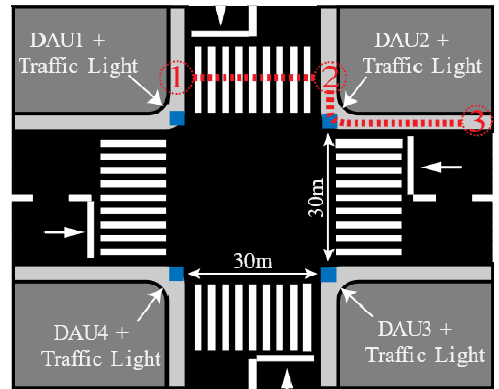
Fig. 3. A signaled traffic intersection composed by for edges. At each edge there is a traffic light that incorporates a Data Acquisition unit (DAU). Table 1. Devices used, brand, model and version of the operating system